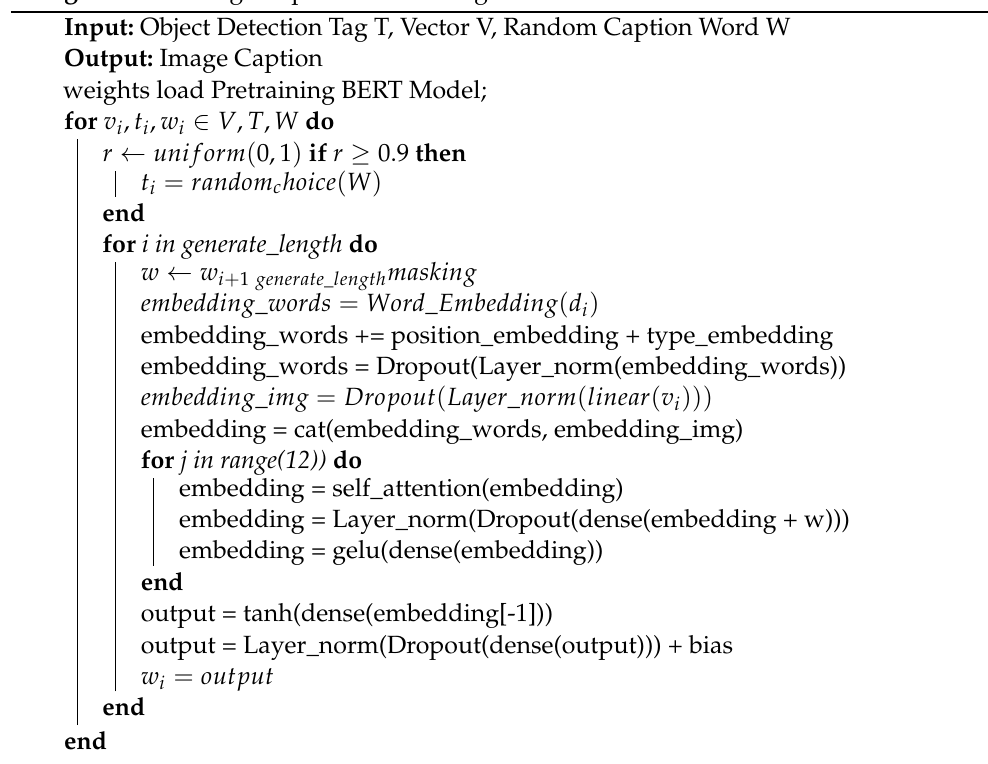
Algorithm 1: Image Caption Fine